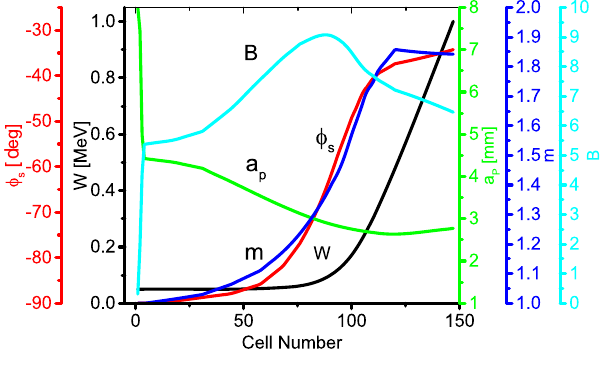
FIG. 2. RFQ design parameters after optimization.